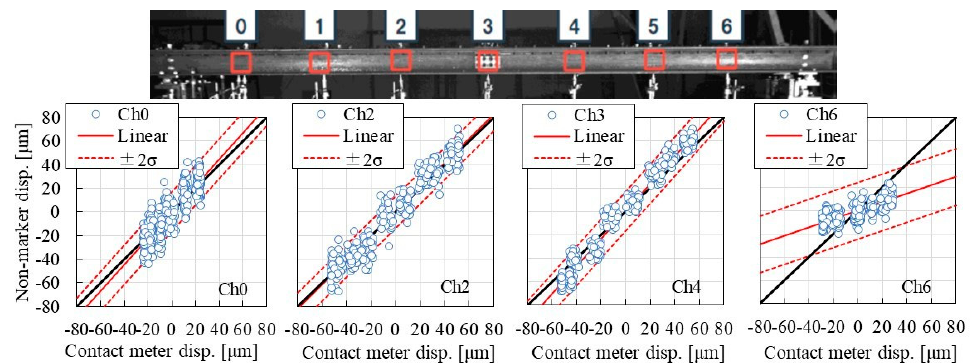
Figure 10. Accuracy of non-marker image measurement (35 Hz excitation at the midspan).